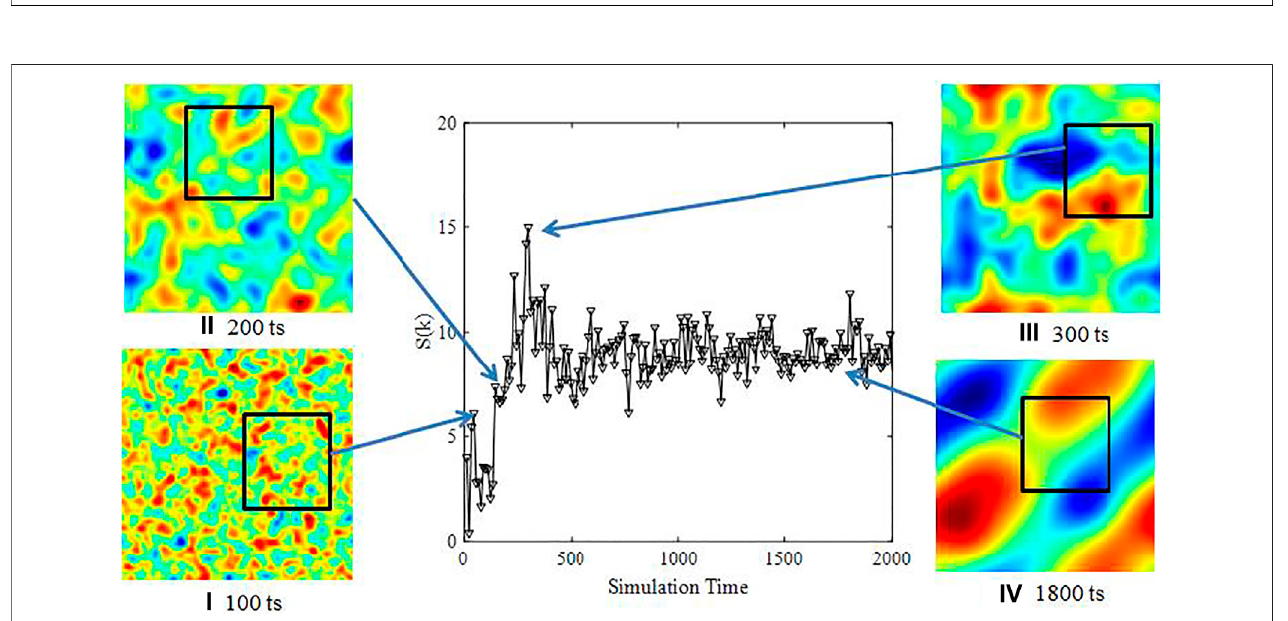
FIGURE4| Temporalevolutionofmeanstructurefactorsoverentiredomaininthephaseseparationsystemwithinteractivestrengthsof G (cid:2) − 1atfourtimes: (A) 100ts, (B) 200 ts, (C) 300 ts, and (D) 1800 ts.